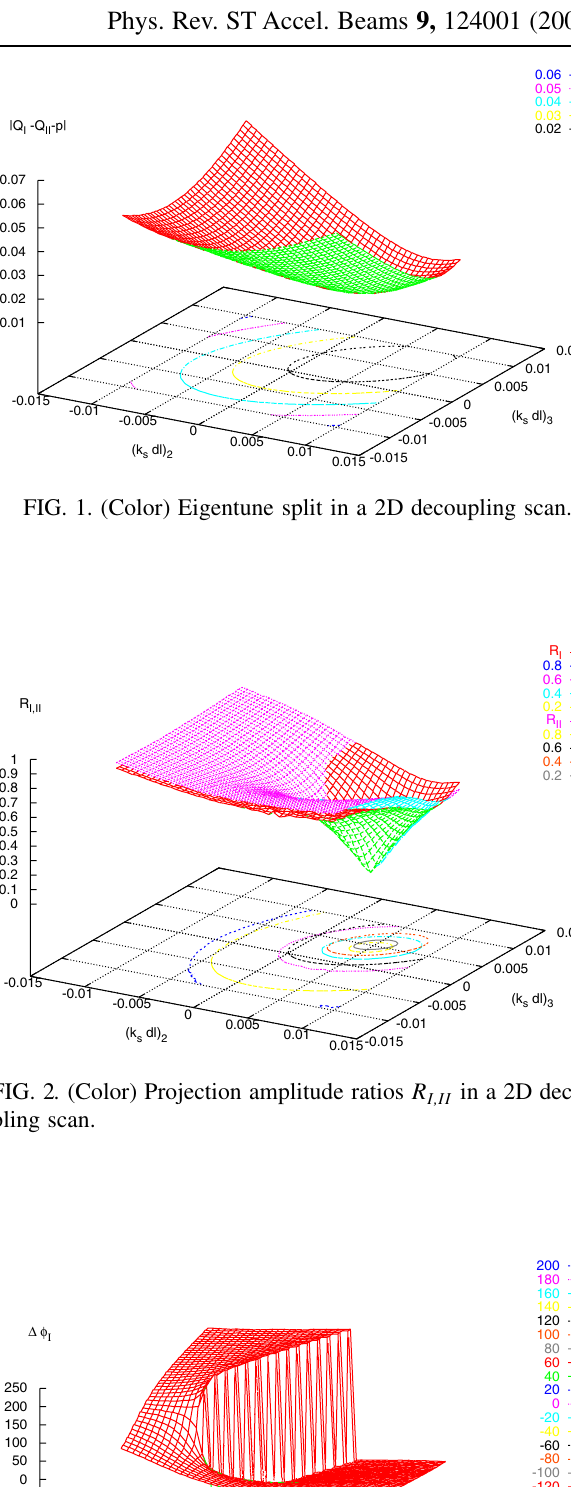
in a 2D decou- I